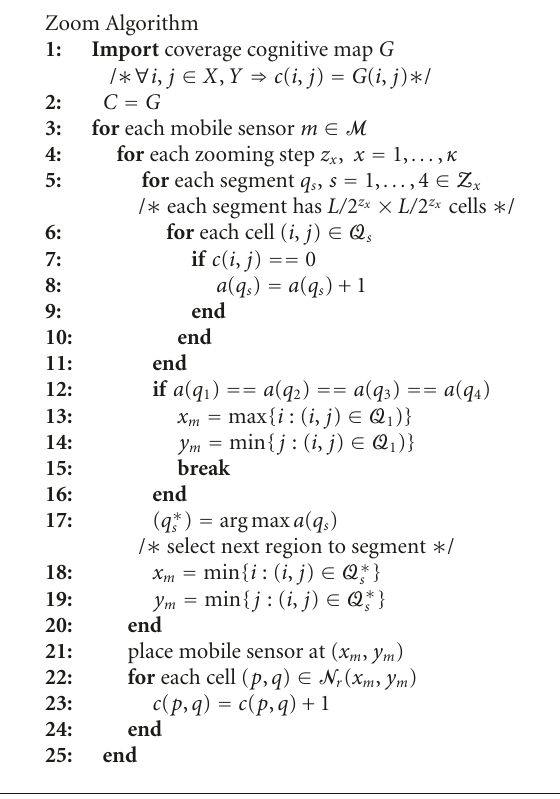
Algorithm 1: Pseudocode for the Zoom